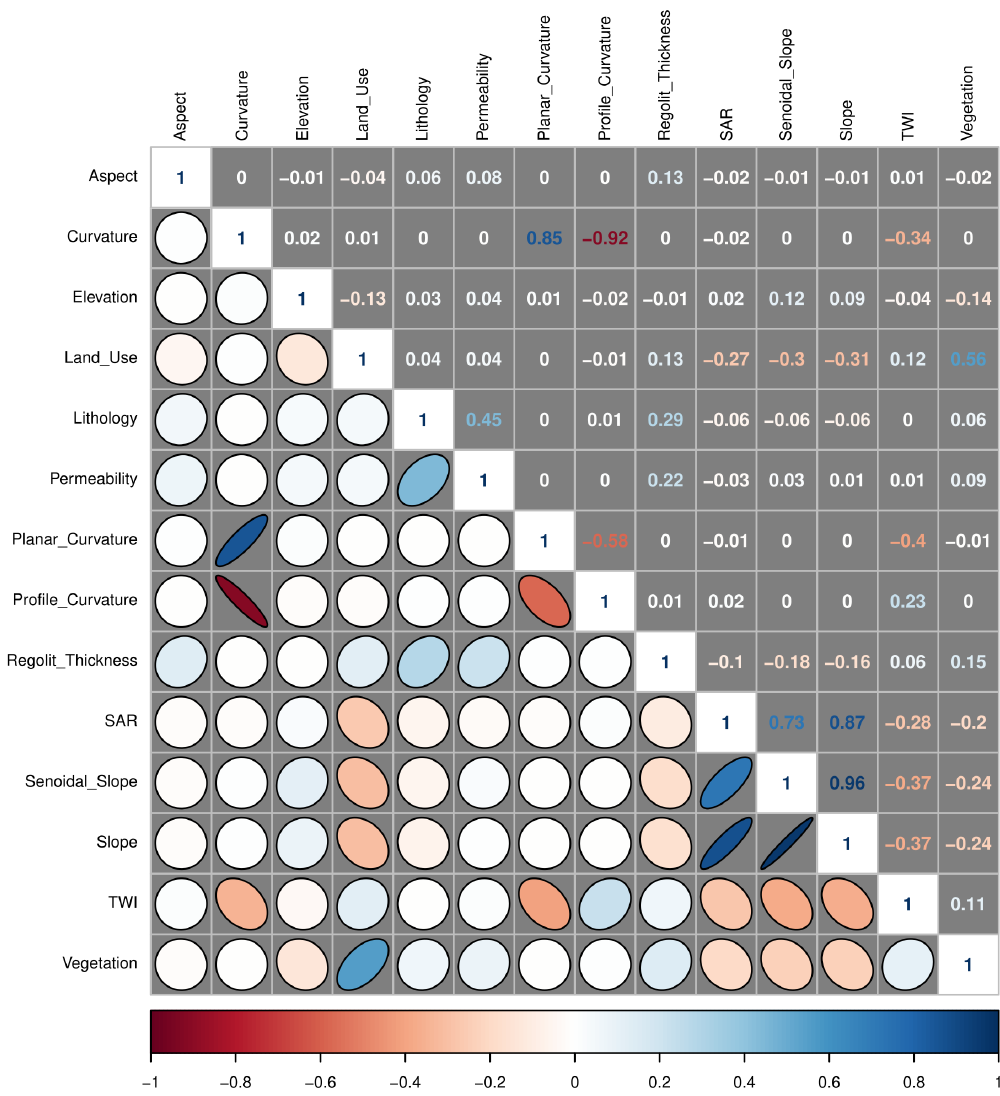
Figure 6. The figure shows the correlogram obtained by LAND-SVA for the complete set of variables available in the Gipuzkoa study area (Case